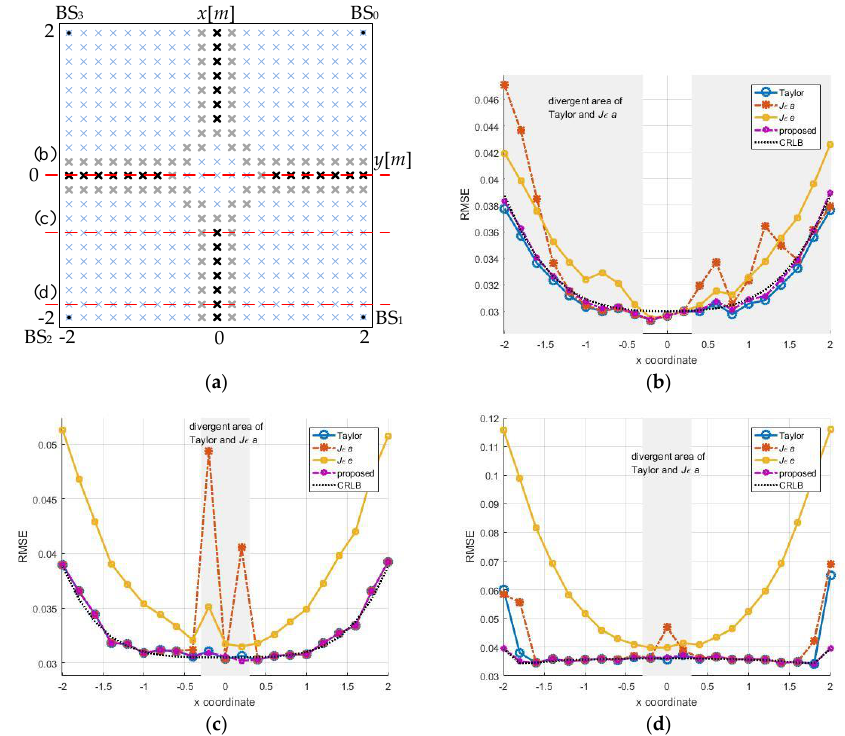
Figure 12. Profile analysis, σ = 0.03 m, the number of simulations is 2000. ( a ) Top view, ( b ) y = 0,